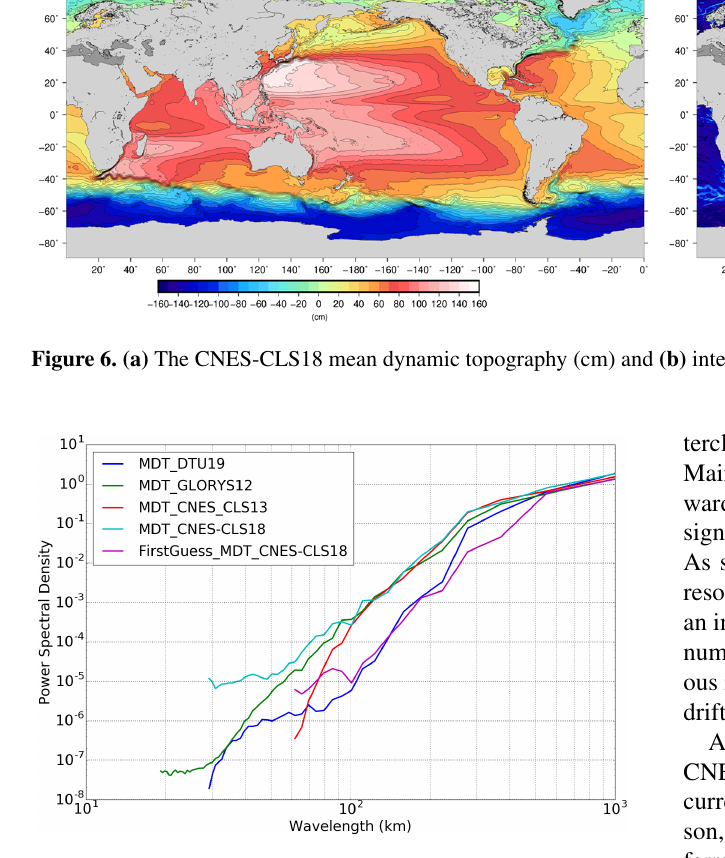
Figure 7. Meridional spectral power density obtained for different MDT solutions in a 10 ◦ box centered around (49 ◦ S, 43 ◦